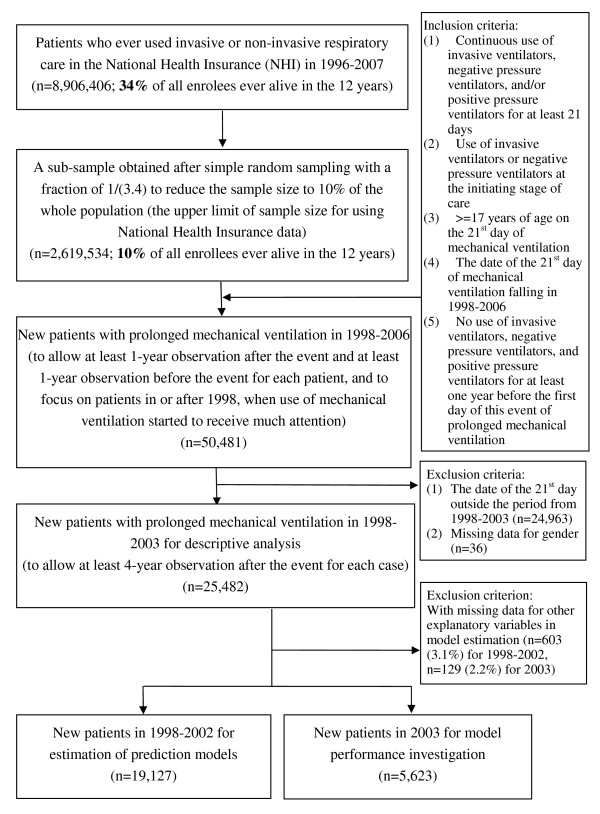
Flow diagram of the selection process of study subjects.